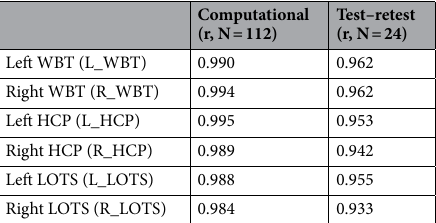
Table 1. Evaluation of computational and test–retest reproducibility for arcuate fasciculus mean FA values for the three methods.